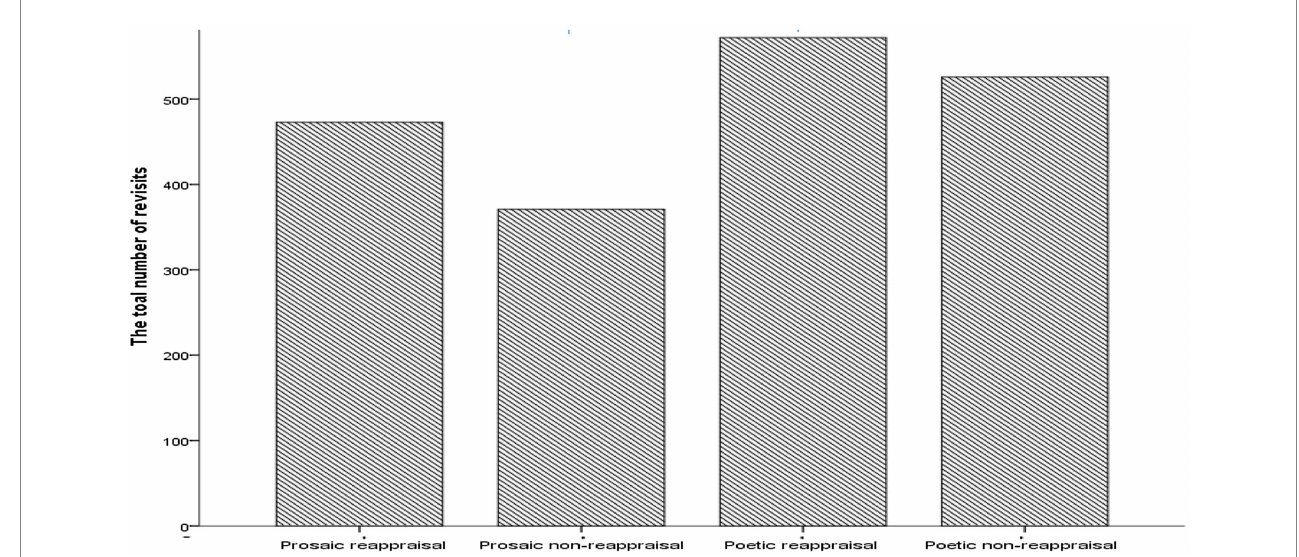
FIGURE 2 Bar graph showing the total number of regressive eye movements by text type. Poetic reappraisal > prosaic non-reappraisal; p = 0.002.